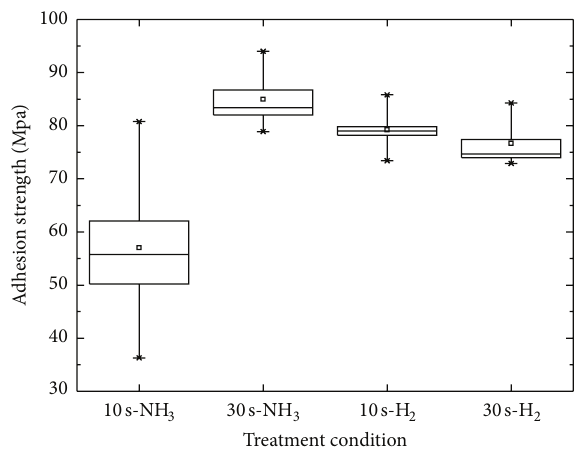
Figure 5: Adhesion strength at the Cu/SiN interface for various plasma treatment conditions.